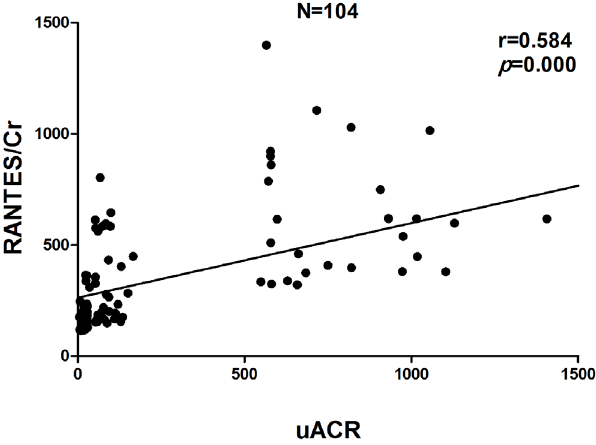
Figure 7. Correlation between urinary RANTES excretion rate and uACR.